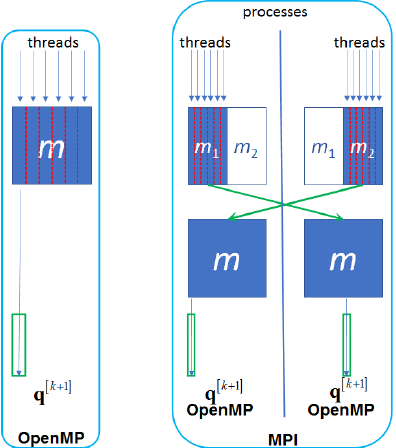
Figure 2. Single-process ( left ) and multiple-process ( right ) parallelization schemes for the algorithm’s iterations. Parallelization is achieved by concurrent calculation of the rows of sensitivity operator matrix m . Green box corresponds to the green box in Figure 1 (sequential part of the iteration, i.e., inverting m and building